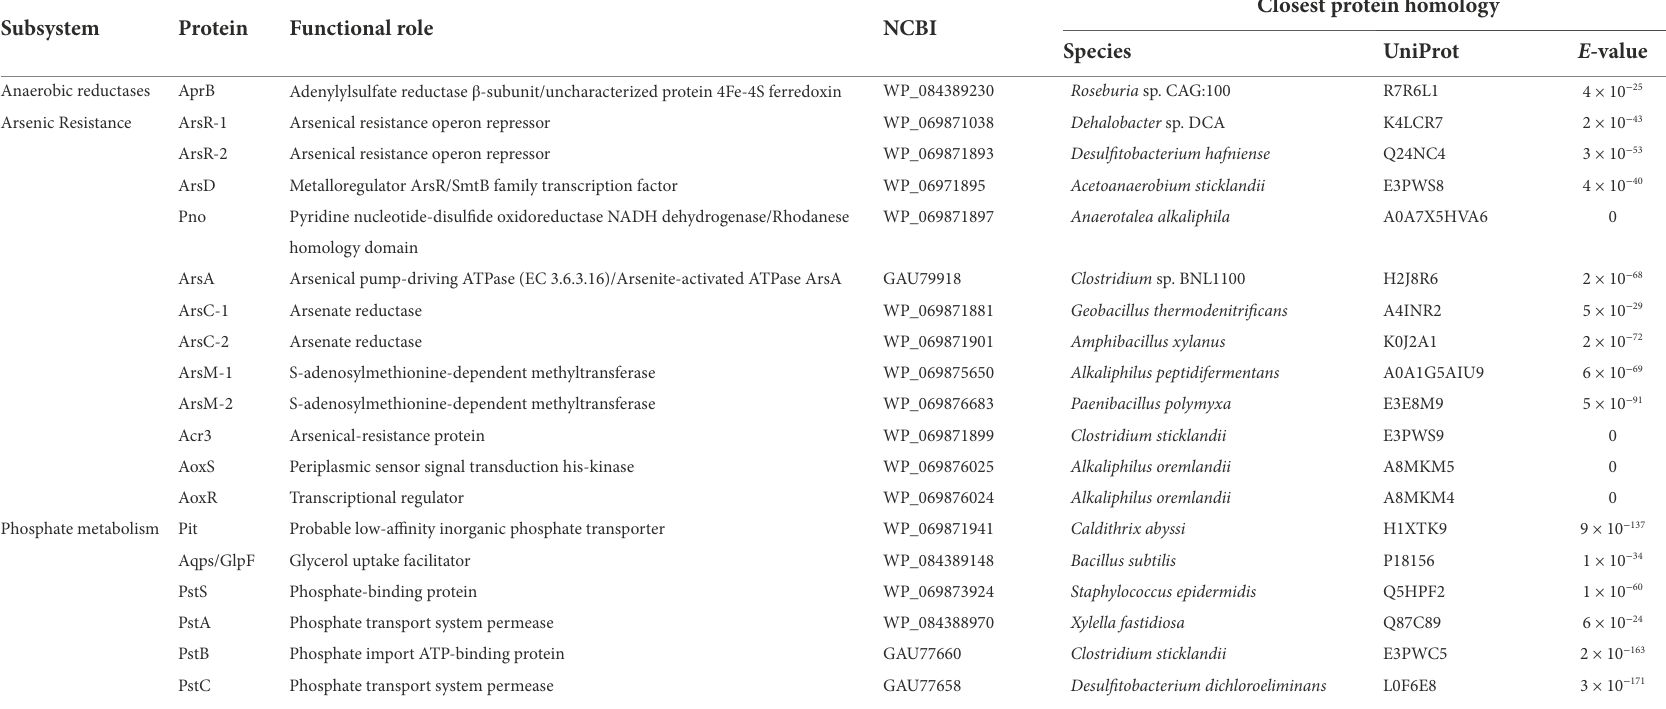
TABLE 2 BLAST results (UniProtKB reference proteomes+SwissProt databases) of predicted proteins related to arsenic resistance, phosphate, and sulfur metabolisms in Fas .